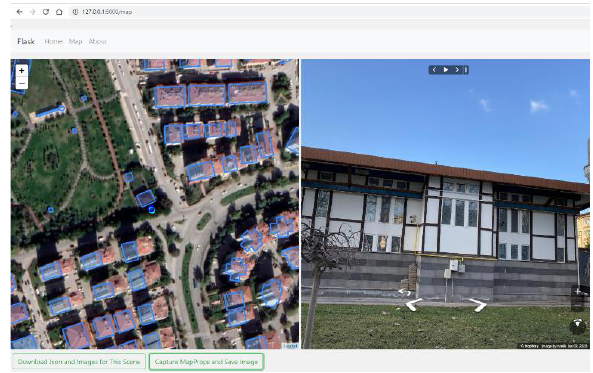
Figure 2. Sample query for Overpass API returns building data within specified coordinates (the extent of the map in the web application)